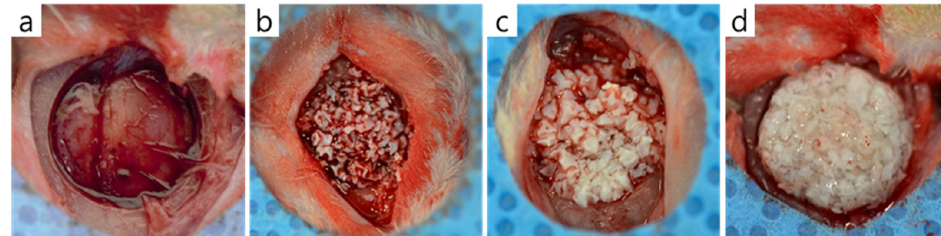
Figure 1. The bone graft materials applied to rat calvaria defects. ( a ) Control group, ( b ) Bio-Oss group, ( c ) Bone-XB group, and ( d ) S1-XB group.